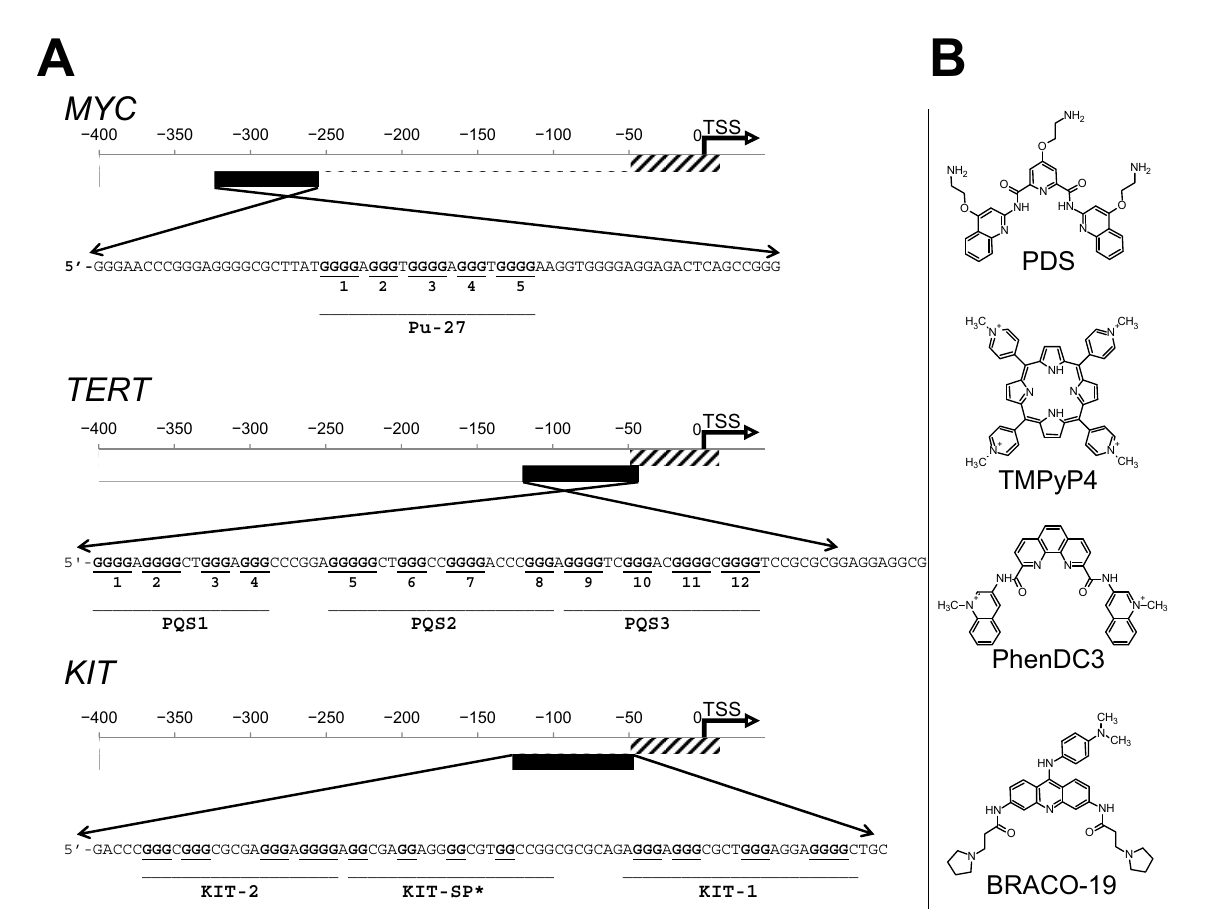
Figure 1. ( A ) Interplay of G4 in PQS in promoter regions of a genes MYC, TERT, and KIT . G-runs involved in canonical G4 structures marked with bold and underlined. The names of the canonical G4 structure are under the line that combines the G-runs. TSS corresponds to an alternative transcription start site from EPDnew [21]. ( B ) Schematic representation of compounds used as a tested G4 ligands. Oncogene KIT encodes a tyrosine kinase receptor, which is predominantly